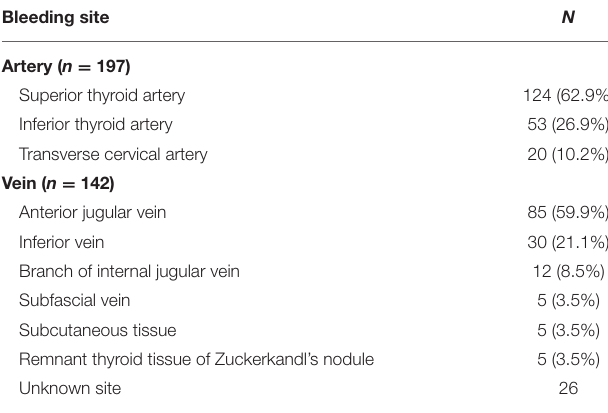
TABLE 1 | Distribution of bleeding